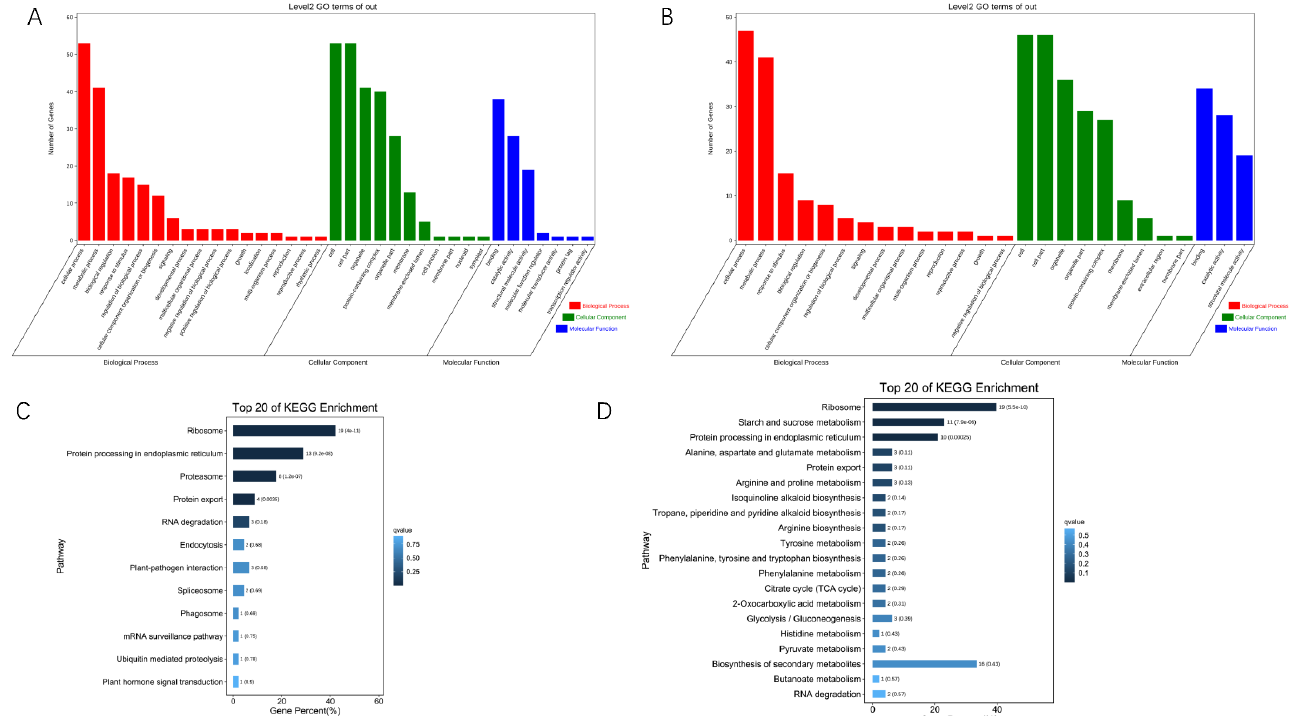
Figure 5. GO annotations ( A , B ) and KEGG enrichment ( C , D ) analysis of candidate–hub genes of IR64 ( A , C ) and Koshihikari ( B , D ). The x -axis of GO annotation shows GO terms at BP, CC and MF. The y -axis shows the number of genes correlating to the GO terms. The x -axis of the KEGG enrichment shows the gene percent of KEGG terms. The y -axis shows the KEGG enrichment terms.